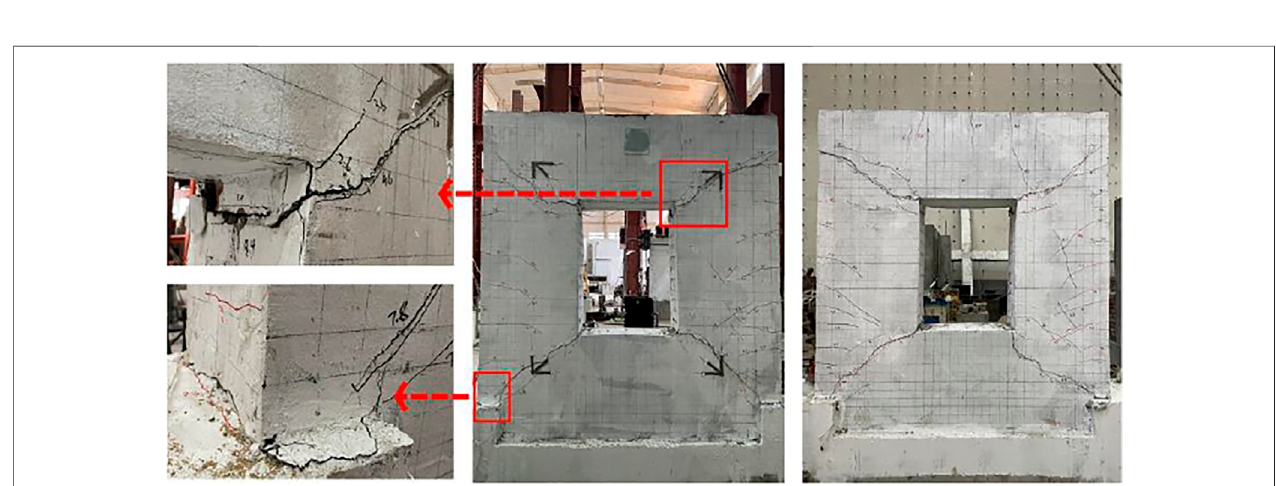
FIGURE 9 | Failure mode and crack pattern for DRUW-7 at ultimate displacement.